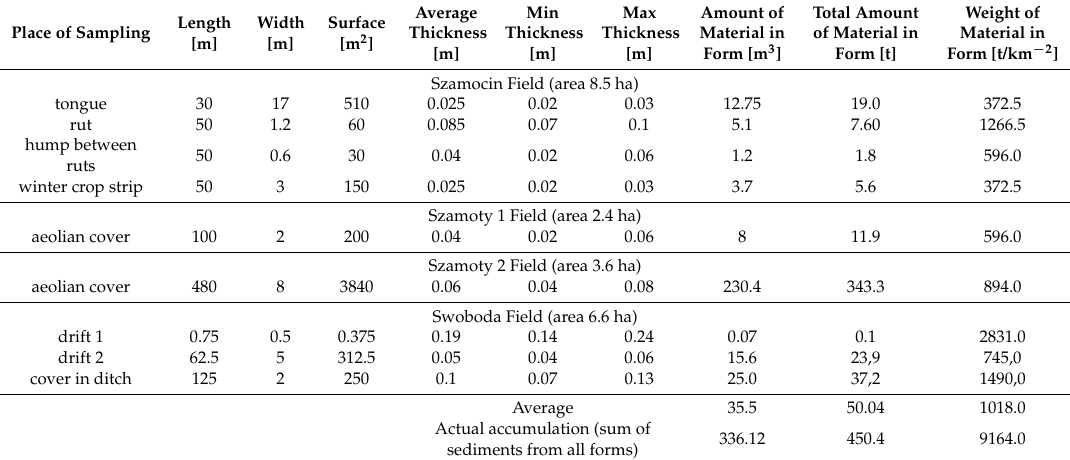
Table 2. Morphometric and volumetric characteristics of accumulative forms in the research area. Place of